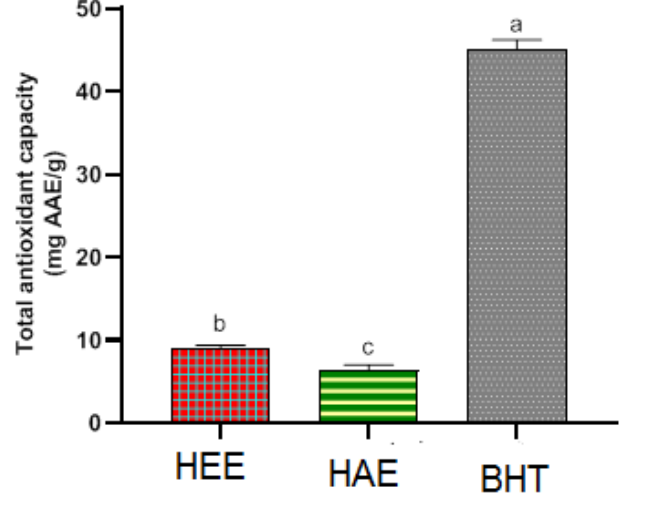
Figure 4. Antioxidant capacity overall of extracts. Means with distinct letters differ from one another significantly ( p < 0.05).